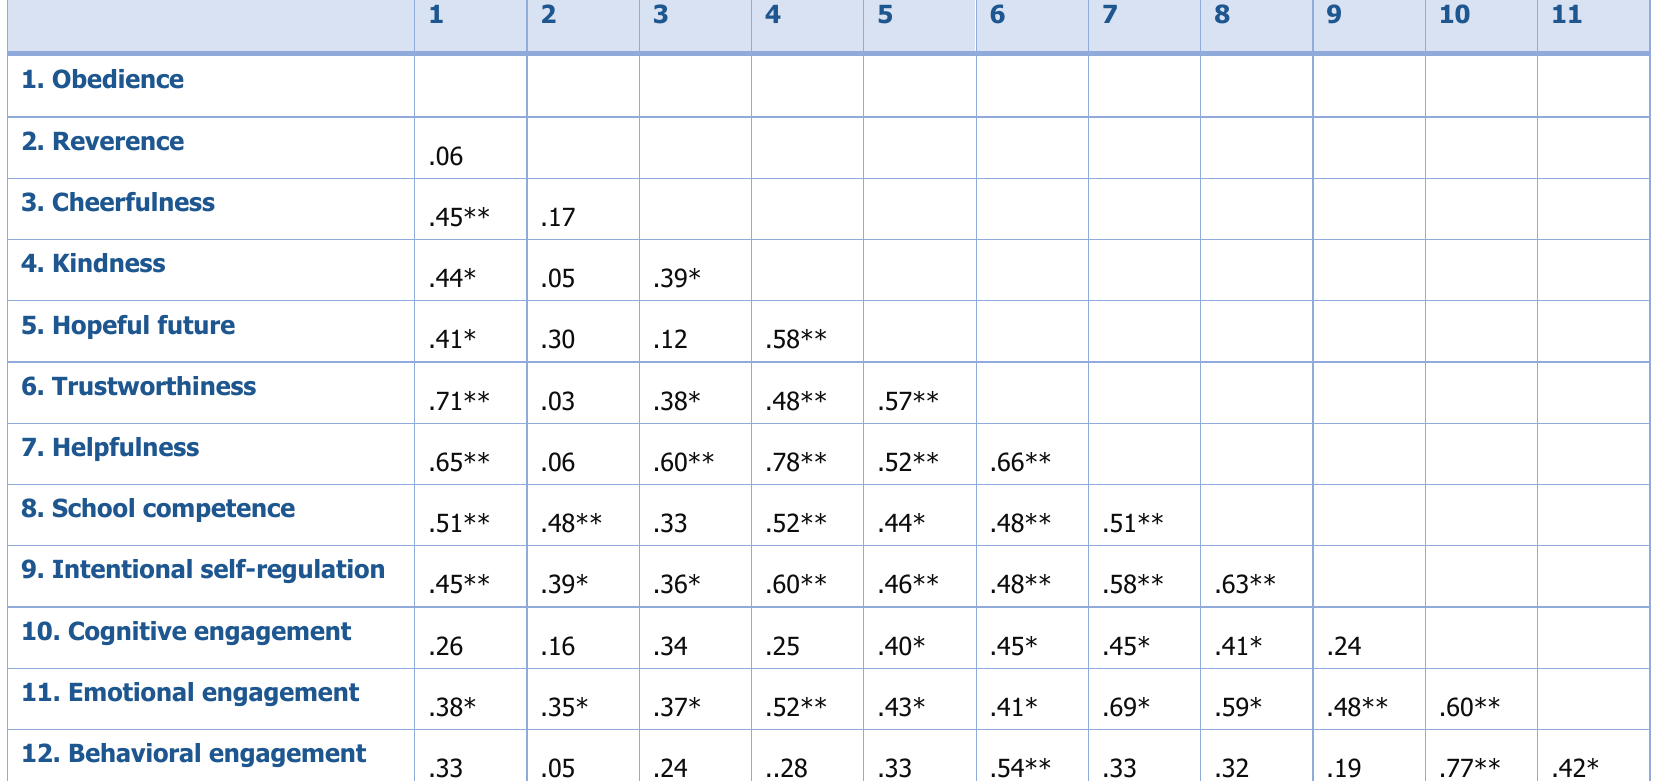
Table 2. Correlations among Dimensions of Engagement, Character Attributes, Self-Perceived School Competence, and Intentional Self-Regulation (n =